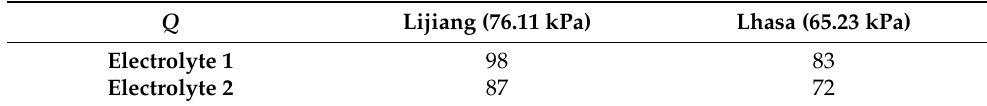
Table 4. The list of average flame centerline temperature for two electrolytes at stable combustion stage and stable combustion with flame color change stage in Hefei (100.09 kPa), Lijiang (76.11 kPa) and Lhasa (65.23 kPa). Average Temperature ( ◦ C) Electrolyte 1 Electrolyte 2 EC/PC/EMC (12/38/50 wt) EC/PC/EMC (38/12/50 wt) Experimental Region Stable Combustion Stable Combustion Stable Combustion Stable Combustion with Flame Color with Flame Color Stage Stage Change Stage Change Stage Hefei (100.09 kPa) 524 405 527 395 Lijiang (76.11 kPa) 679 480 548 Lhasa (65.23 kPa) 730 555